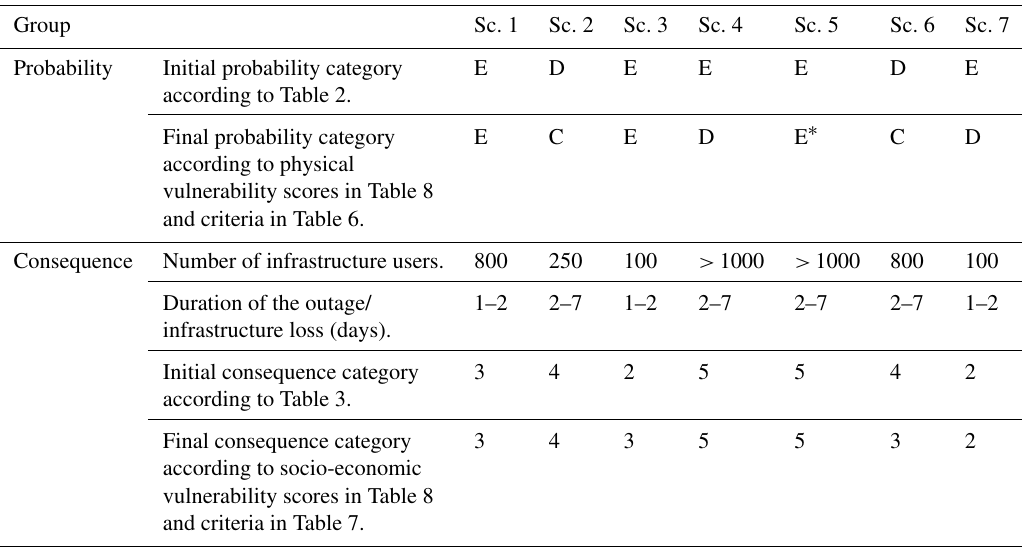
Table 9. Initial and final categorisation of probability and consequence. The difference between the final and initial probability category is determined by the physical vulnerability score. The difference between the final and initial consequence category is determined by the socio-economic vulnerability score. Sc. means